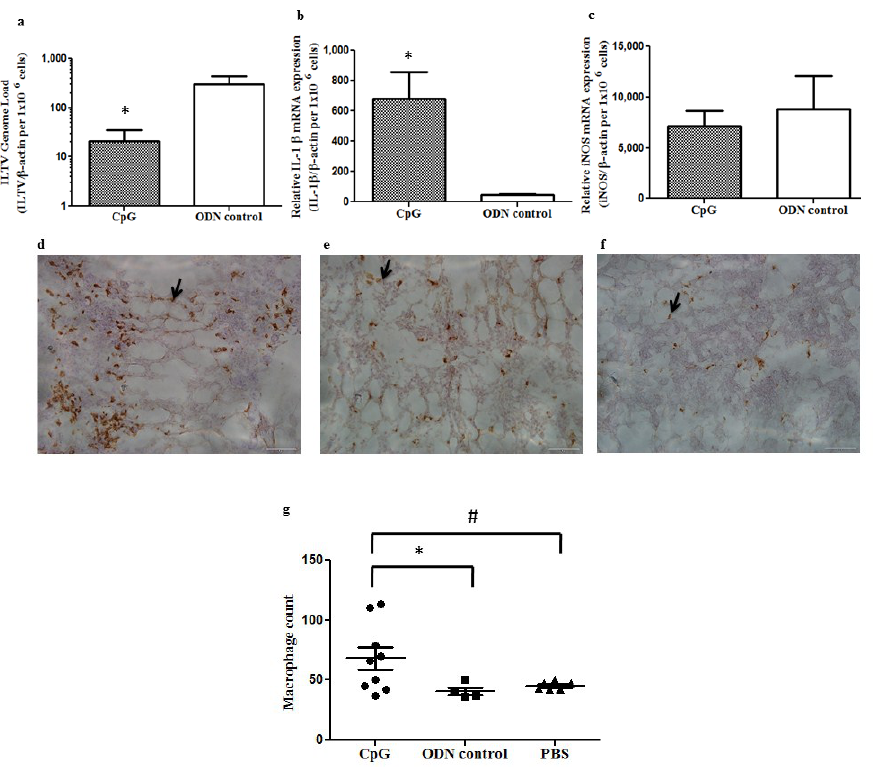
Figure 1. In ovo delivery of CpG DNA reduces ILTV replication pre-hatch in lung of chicken embryos correlating with expansion of macrophage populations and increased mRNA expression of IL-1β in lungs 24 h post treatment: ( a ) pre-hatch mRNA expression of ILTV protein kinase (PK) gene in lungs following in ovo CpG DNA or PBS delivery; ( b – c ) mRNA expression of IL-1β ( b ) and iNOS ( c ) that will be activated downstream of CpG DNA- TLR21 interaction following in ovo CpG DNA or PBS delivery; ( d ) macrophages in lungs pre-hatch following in ovo delivery of CpG DNA, non-CpG DNA and PBS 24 h post treatment (ED19). Arrows show KUL01+ macrophages * = significant at p ≤ 0.05 when CpG DNA treated and non-CpG DNA treated groups were compared and #= significant at p ≤ 0.05 when CpG DNA treated and PBS treated groups were